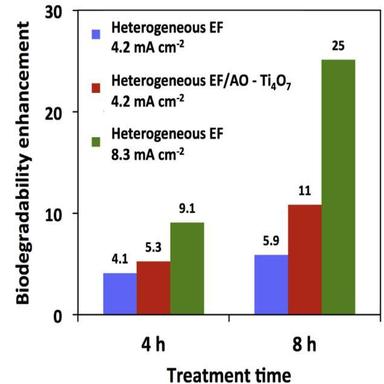
Biodegradability enhancement at two different treatment times for different EAOPs and current densities.